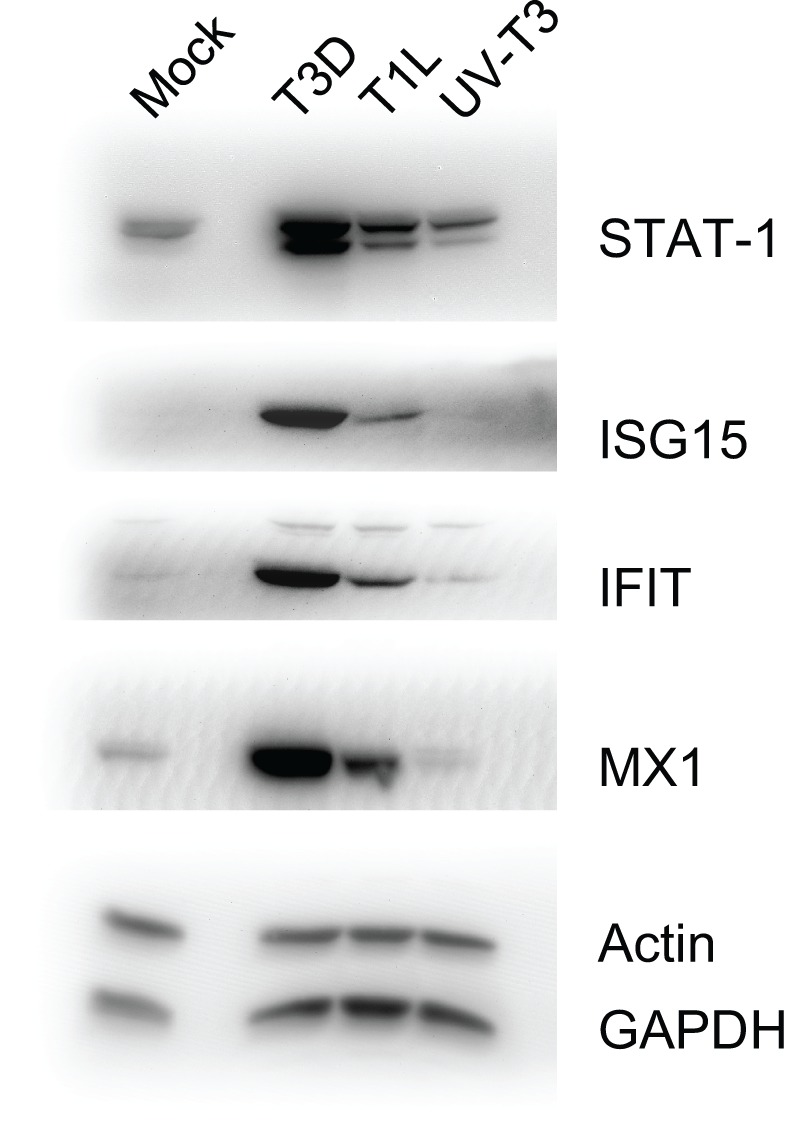
Immunoblot analyses of indicated host proteins in HeLa cells mock-infected, or infected with T3D or T1L, or treated with UV-inactivated T3D. Cells were harvested and lysed with 0.5% NP-40 detergent, nuclei removed, and cytosolic fractions dissolved in SDS electrophoresis sample buffer, resolved in 10% mini SDS-PAGE, transferred to PVDF, and probed with various antibodies. Bands were visualized, and intensities measured, with an Alpha Innotech FluorChem®Q MultiImage® III instrument.